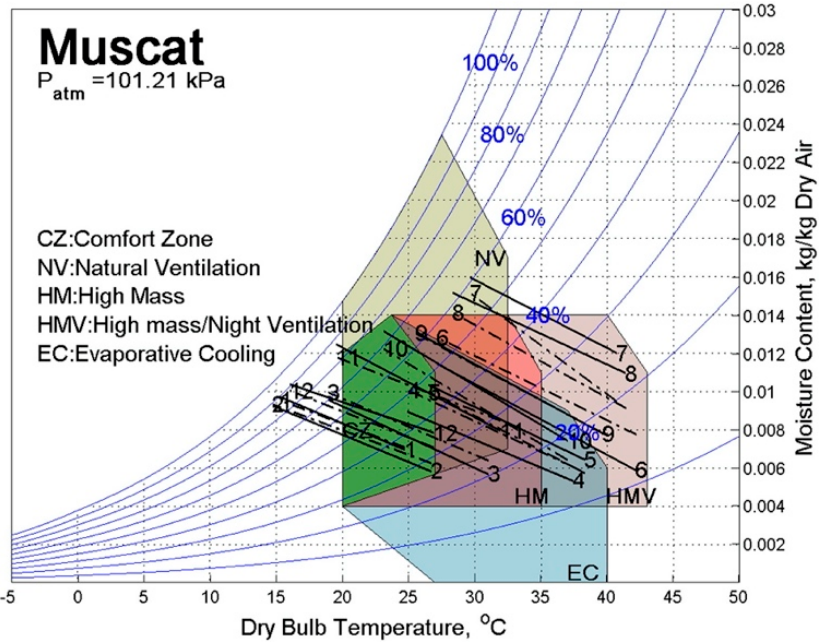
Figure 3. Bioclimatic chart for Muscat. Solid lines are for months from normal Typical Metrological Years (TMY), while dashed lines are for months from TMY developed for passive cooling [29,30].